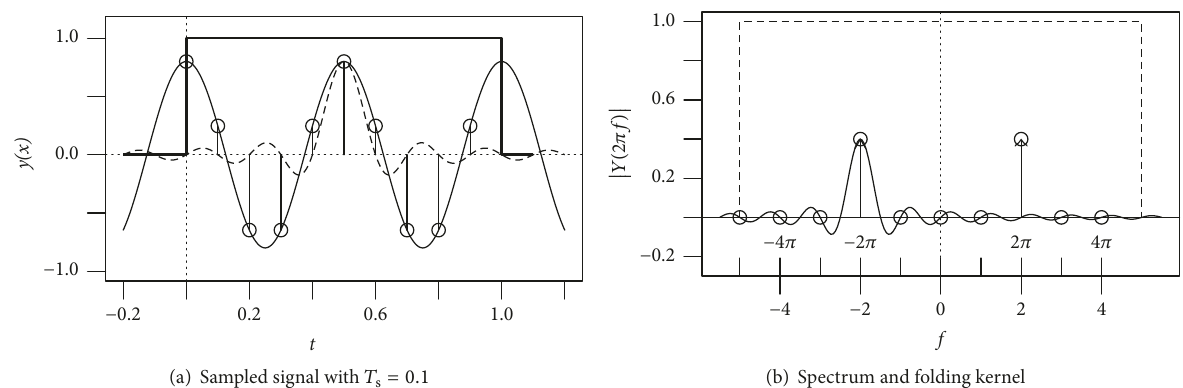
Figure 9: In (a), the function 𝑦(𝑡) from (48) is sampled in the time range 0 ≤ 𝑡 < 1 . The finite time interval corresponds to a rectangular weight function. The continuous spectrum (arrows in (b)) is then convoluted with the spectral representation of that rectangular window. The black line indicates the convolution step for one left spectral part. Note that only the Dirac impulse generates a value, because all other components remain zero. The dashed line in (b) indicates the limitation to a maximum frequency, which corresponds to a convolution in the time domain (a). Open symbols show the sampling (a) and the result of the DFT (b).